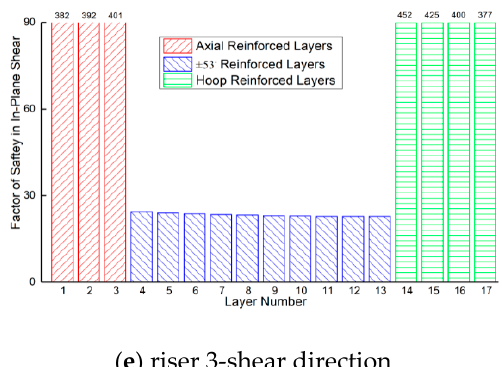
Figure 15. Factor of safety of composite layers for 2.13 m/s in ( a ) riser 2 ‐ fiber direction, ( b ) riser 2 ‐ transverse direction, ( c ) riser 3 ‐ fiber direction, ( d ) riser 3 ‐ transverse direction and ( e ) riser 3 ‐ shear direction.